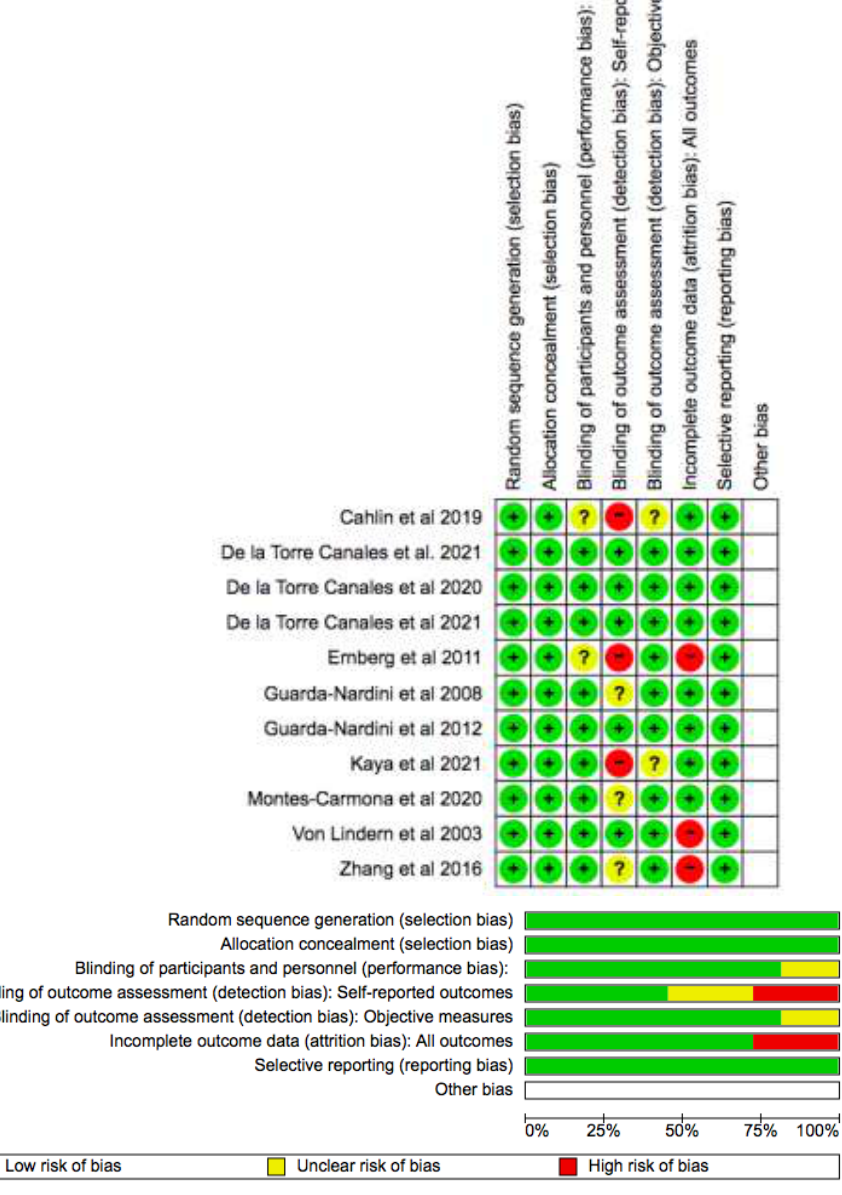
Figure 2. RoB 2 assessment of RCTs. The randomization process reported 100% of the studies with a low risk of bias. Of the studies, 80% excluded a performance bias [23–28,30,31,33] but 75% reported all outcome data [23–25,27,30–33] and 100% of included trials adequately left out bias in the selection of the reported results.[23–33] The overall ranking showed no studies with low risk of bias. Only 4 out of 11 RCT studies were shown to have a low risk of incurring bias.